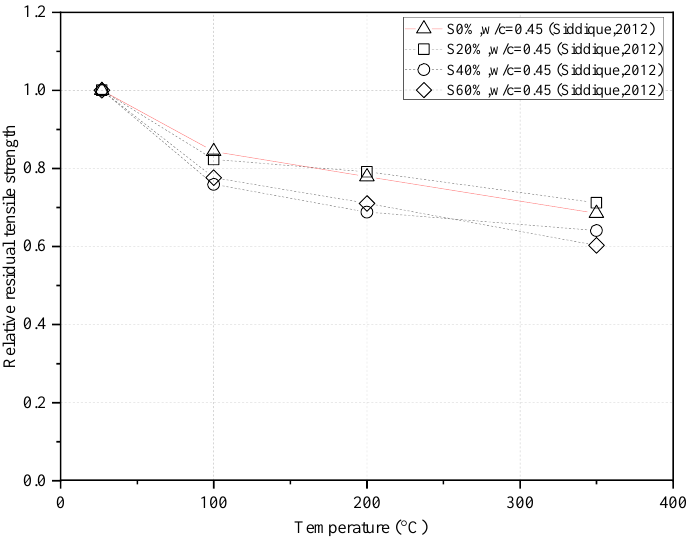
Figure 10. The relative residual splitting tensile strength of concrete containing slag (S) and water-to-cementitious materials ratios (w/c) of 0.45 [32].